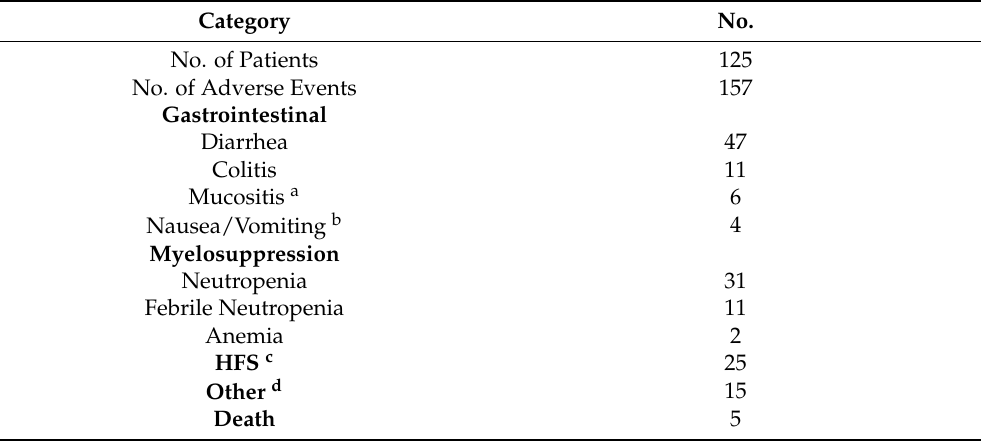
Table 2. Severe Fluoropyrimidine-related Adverse